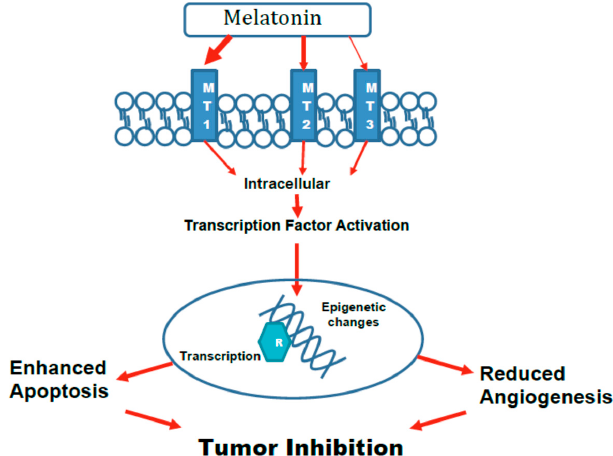
Figure 1. The effects of melatonin on carcinogenesis that directly Inhibit tumors. Melatonin interacts with its surface receptors to activate intracellular signaling cascades. The size of the arrows reflects the importance of the receptor subtype. Intracellular signaling leads to activation of transcription factors that cause changes to the DNA in a manner that enhance apoptosis of cancer/pre-cancer cells and reduce angiogenesis which is necessary for tumor growth and metastasis.